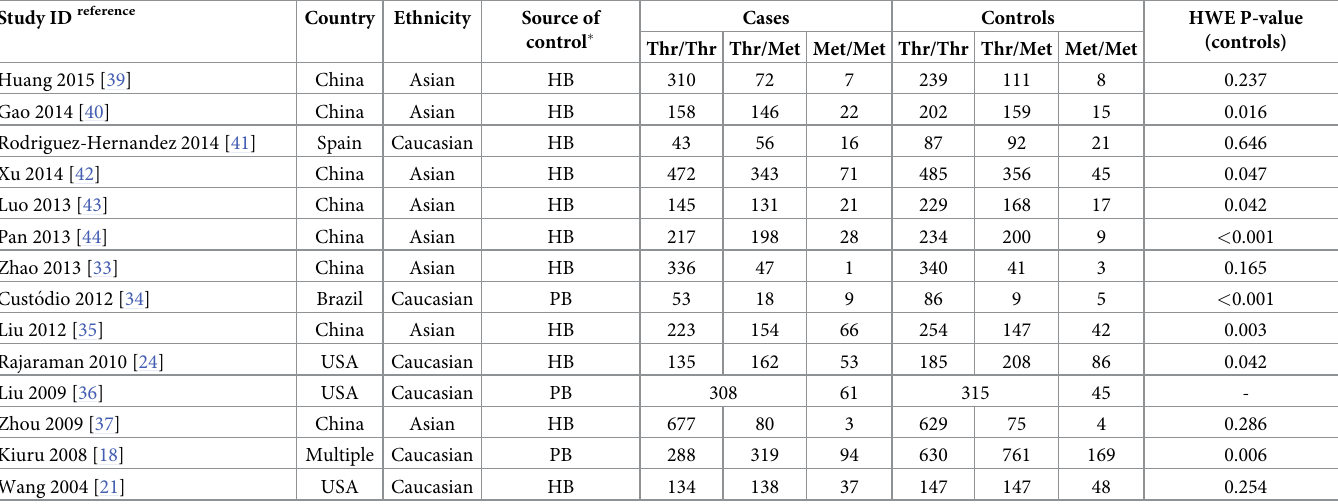
Table 1. Characteristics of the included